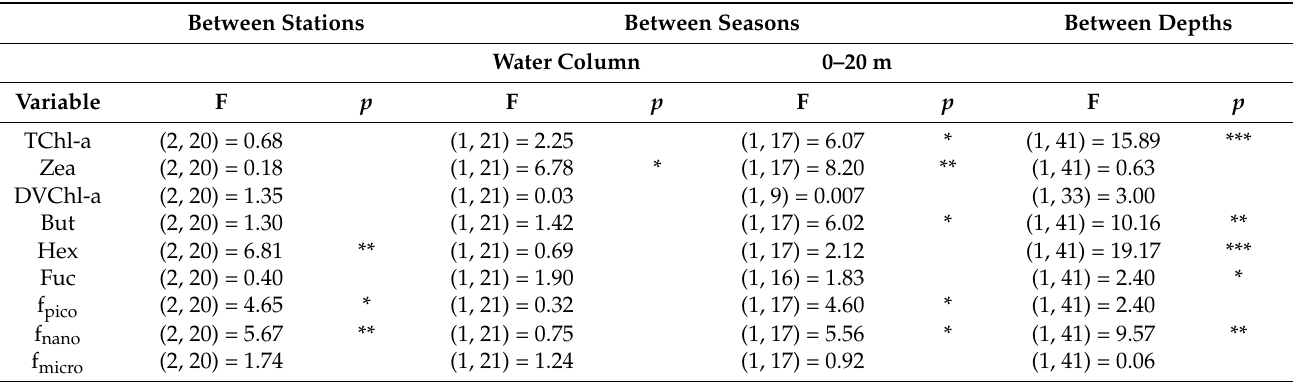
Table 2. Results of one-way ANOVA tests of differences between stations, between seasons, and between depths (0–20 m, >20 m).